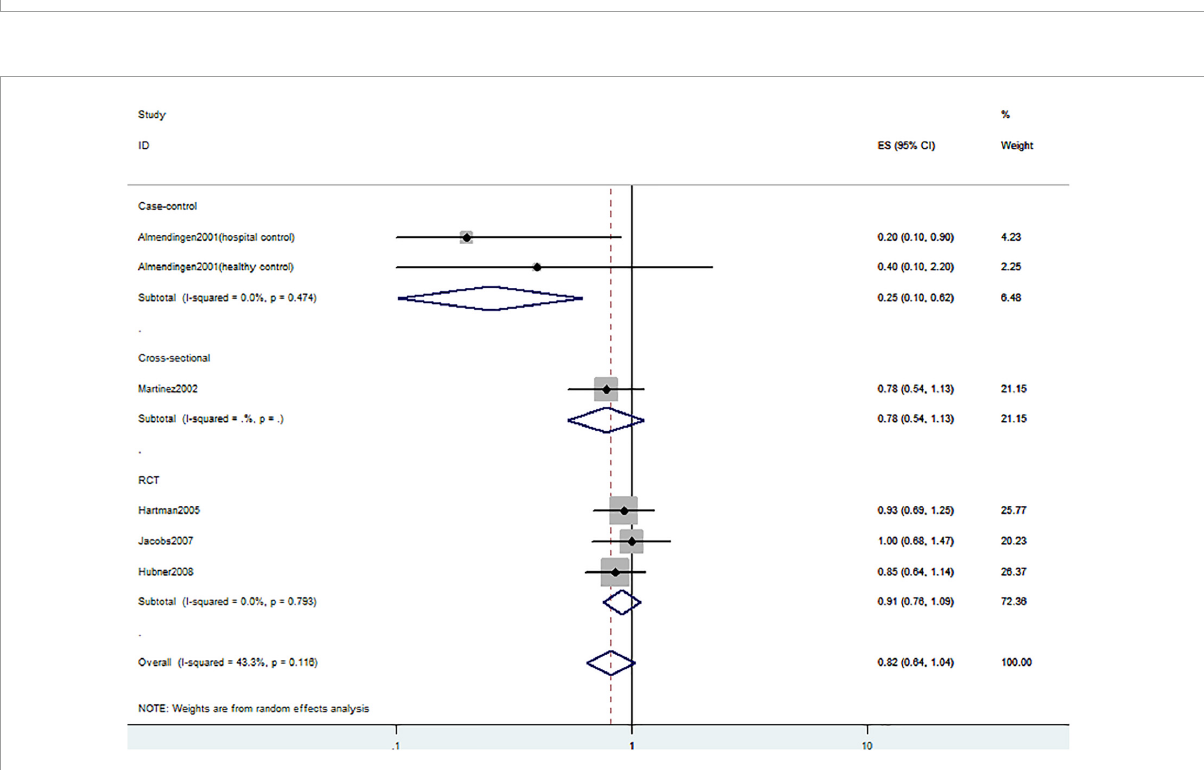
FIGURE6 Random-effects meta-analysis of studies that examined dietary vitamin D intake and risk of CRC precursors recurrence. ES, effect